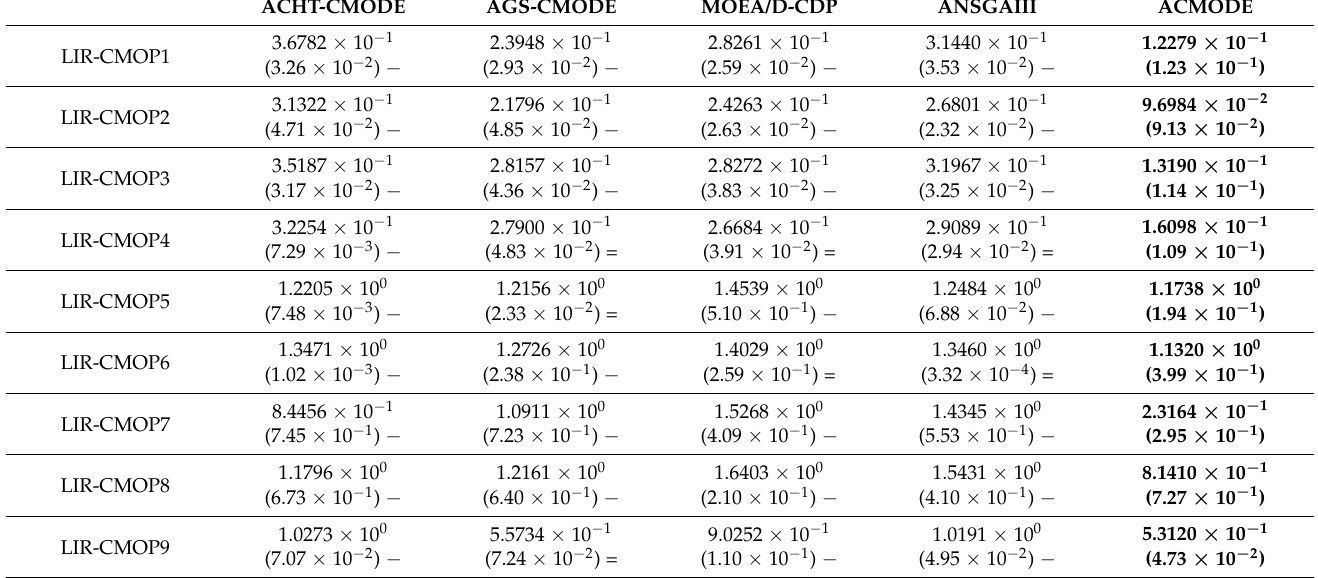
Table 4. IGD results of all comparison algorithms on LIR-CMOP test